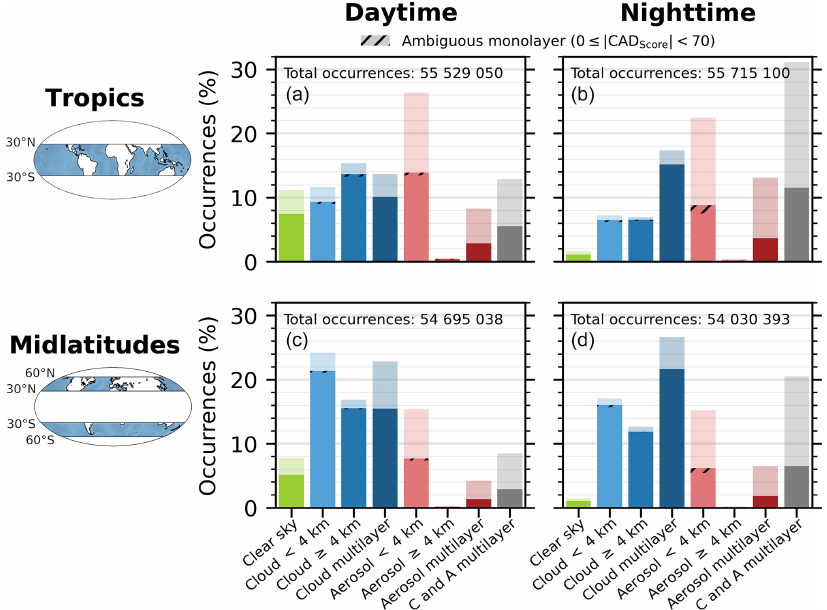
Figure 1. Occurrence of the 5km atmospheric column types derived from the CALIOP L2 5km merged layer data product V4 over ocean dur- ing the 2008–2019 period in the tropics (30 ◦ S–30 ◦ N) (a, b) and the midlatitudes (30–60 ◦ ) (c, d) during daytime (a, c) and nighttime (b, d) . The solid bars show the occurrence frequencies of 5km atmospheric columns in which no clouds were detected at single-shot resolution. The transparent bars show the total occurrence frequencies, i.e., including those columns in which single-shot clouds were detected. For cloud and aerosol monolayer columns (second, third, fifth, and sixth bars), the hatched region of the solid bars shows the CALIPSO V4 CAD ambiguous classification fraction. Layers detected at 80km horizontal averaging are not considered in the calculation of occurrence frequencies. Occurrence frequencies for multilayer columns are shown for reference but are not included in this study. Columns containing a monolayer with special CAD score value are not shown